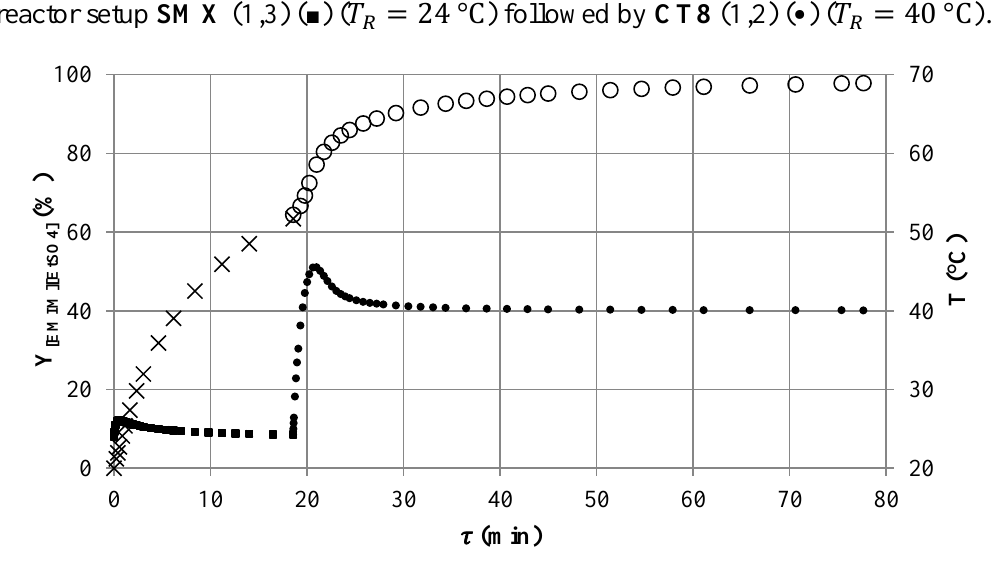
Figure 9. Simulated axial yield profile of [EMIM][EtSO